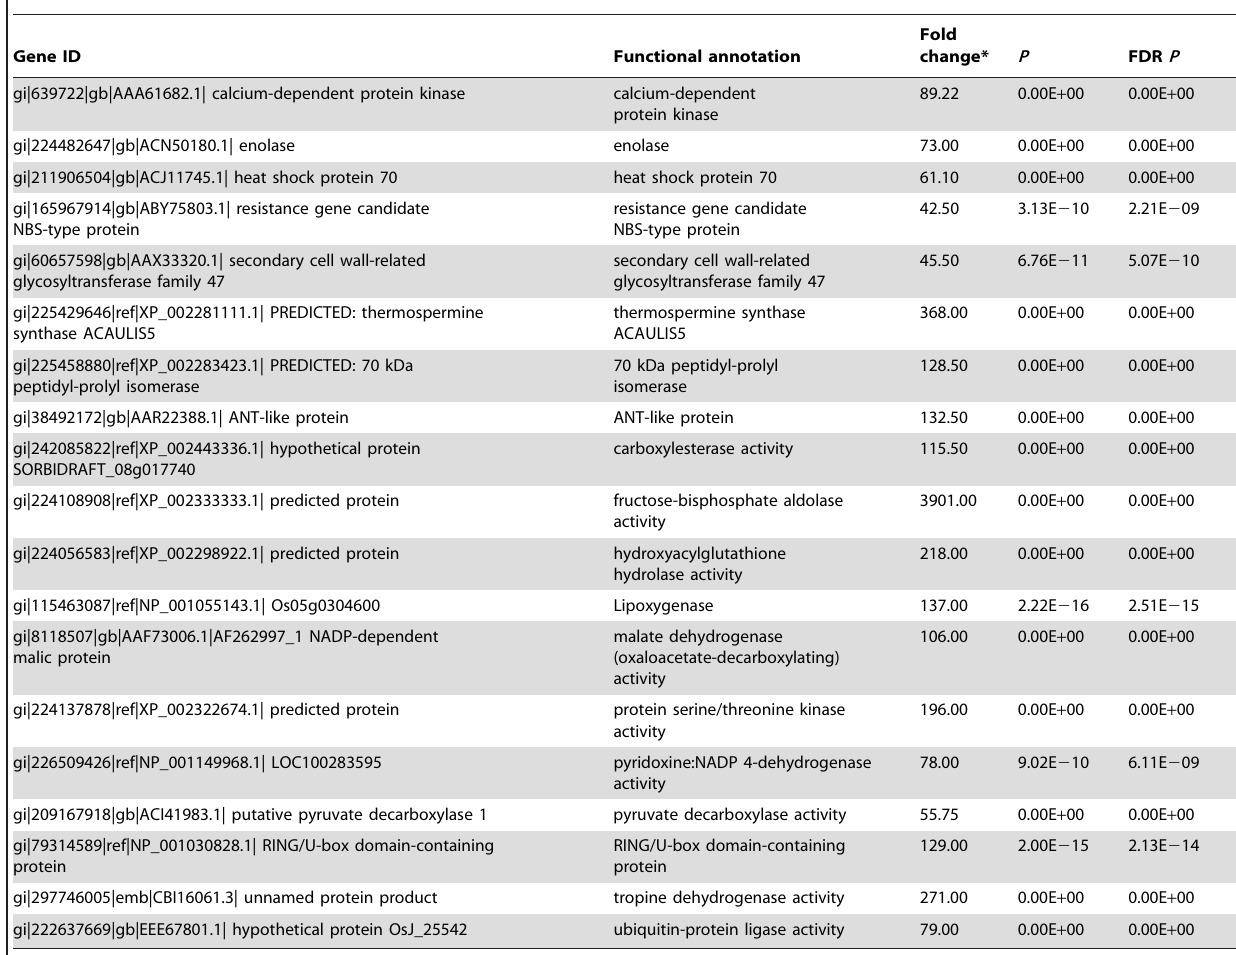
Table 3. List of upregulated genes unique to C. amada during infection with R. solanacearum.